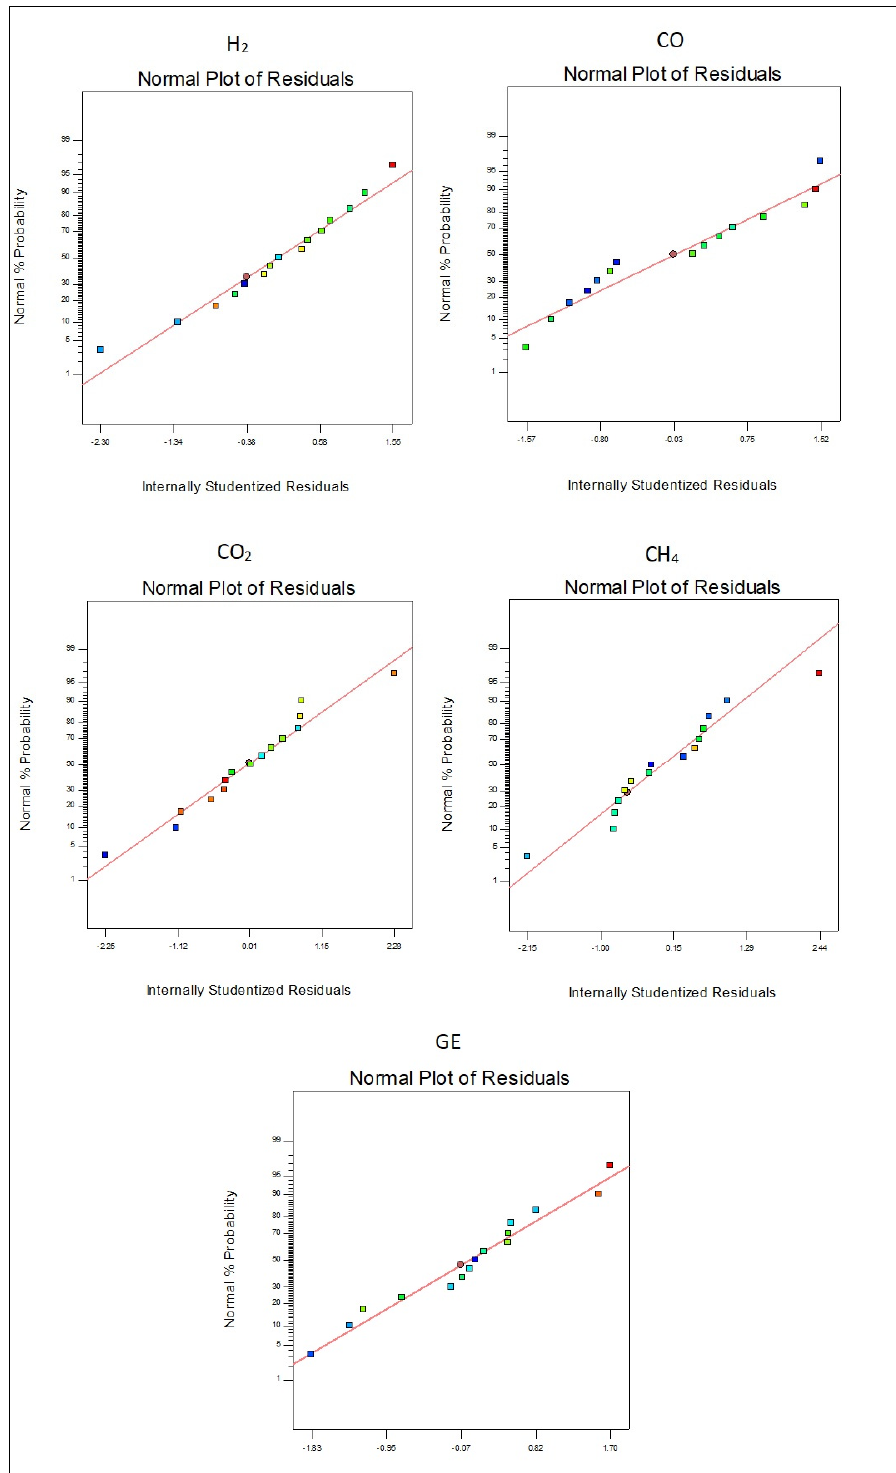
Figure 8. Normal probability plot of residuals.